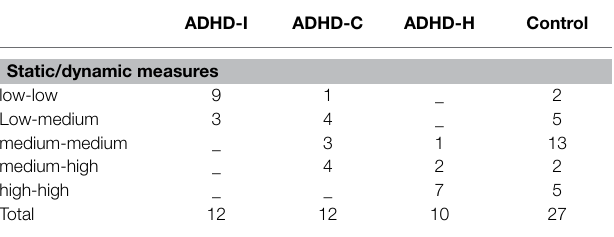
TABLE 4 | Frequency of distribution of the Groups in relation to static and dynamic measures. ADHD-I ADHD-C ADHD-H Control Static/dynamic measures